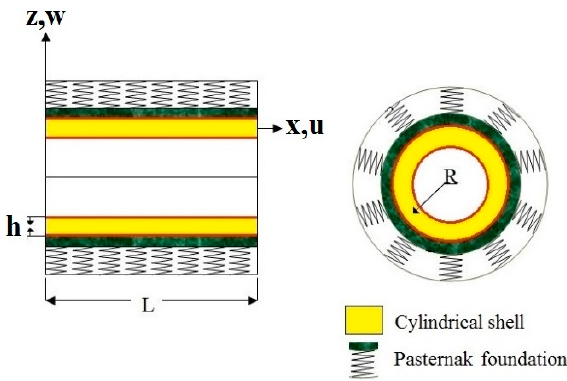
Figure 2. Scheme of the cylindrical pressure vessel surrounded by the Pasternak foundation.